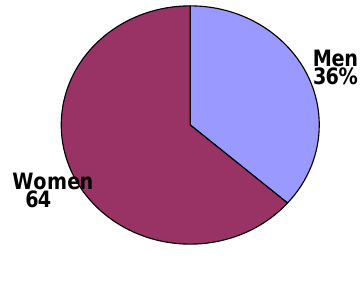
Figure 1. Distribution of samples by